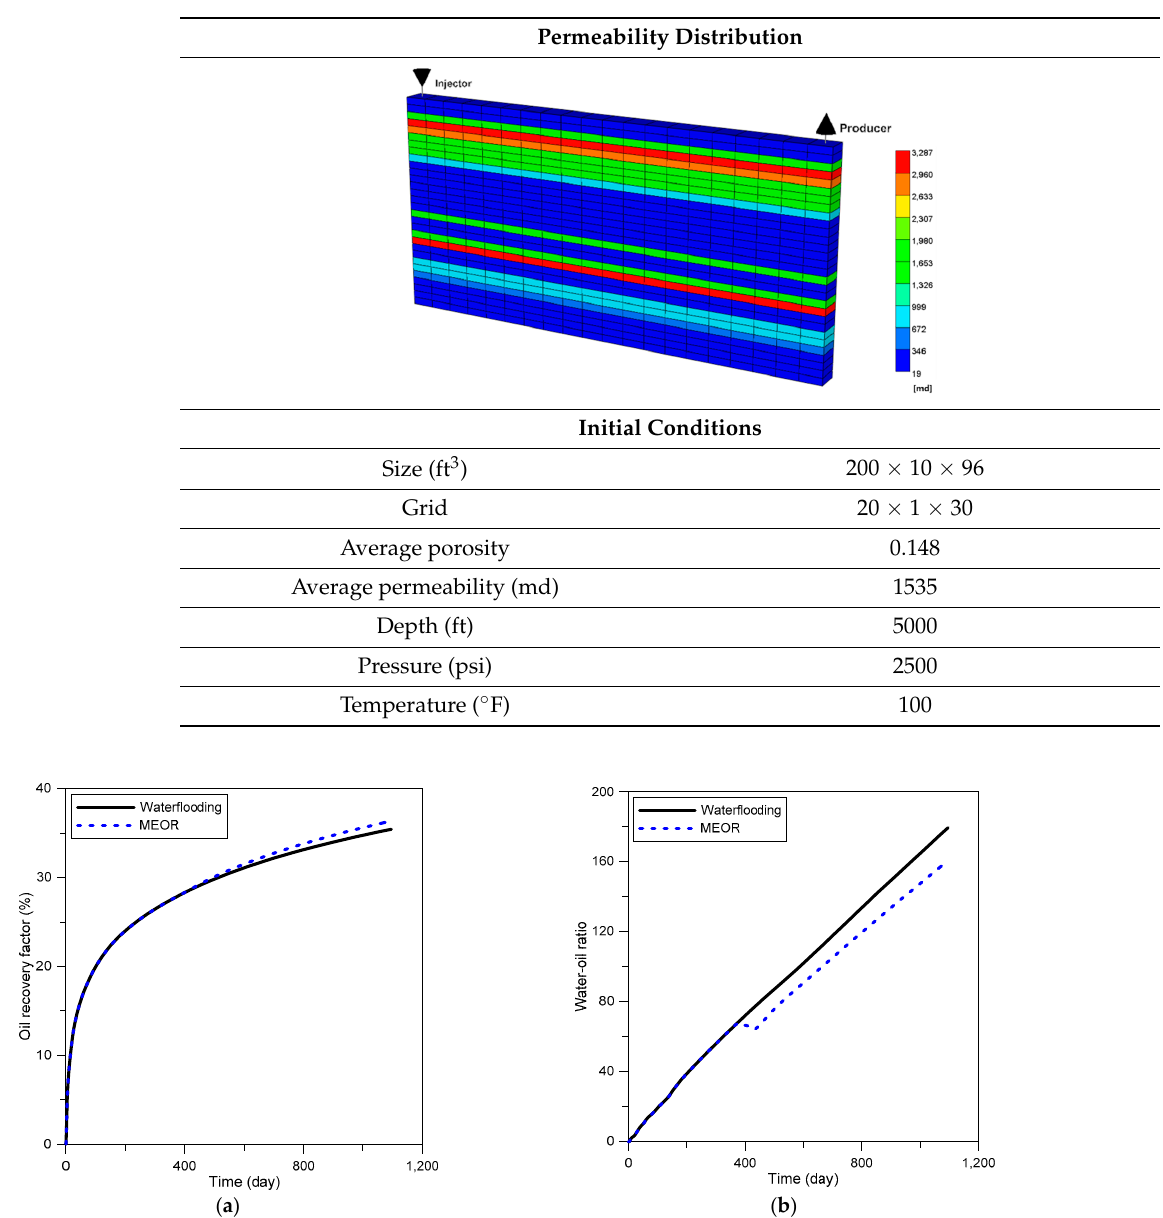
Table 3. Initial conditions of the King Island reservoir.